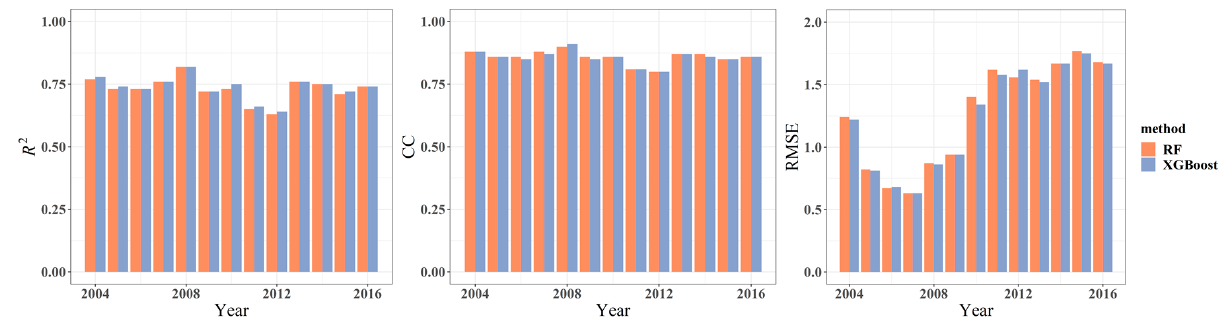
Figure 7. R 2 , CC and RMSE metrics of the RF-modeled and XGBoost-modeled GLDAS.